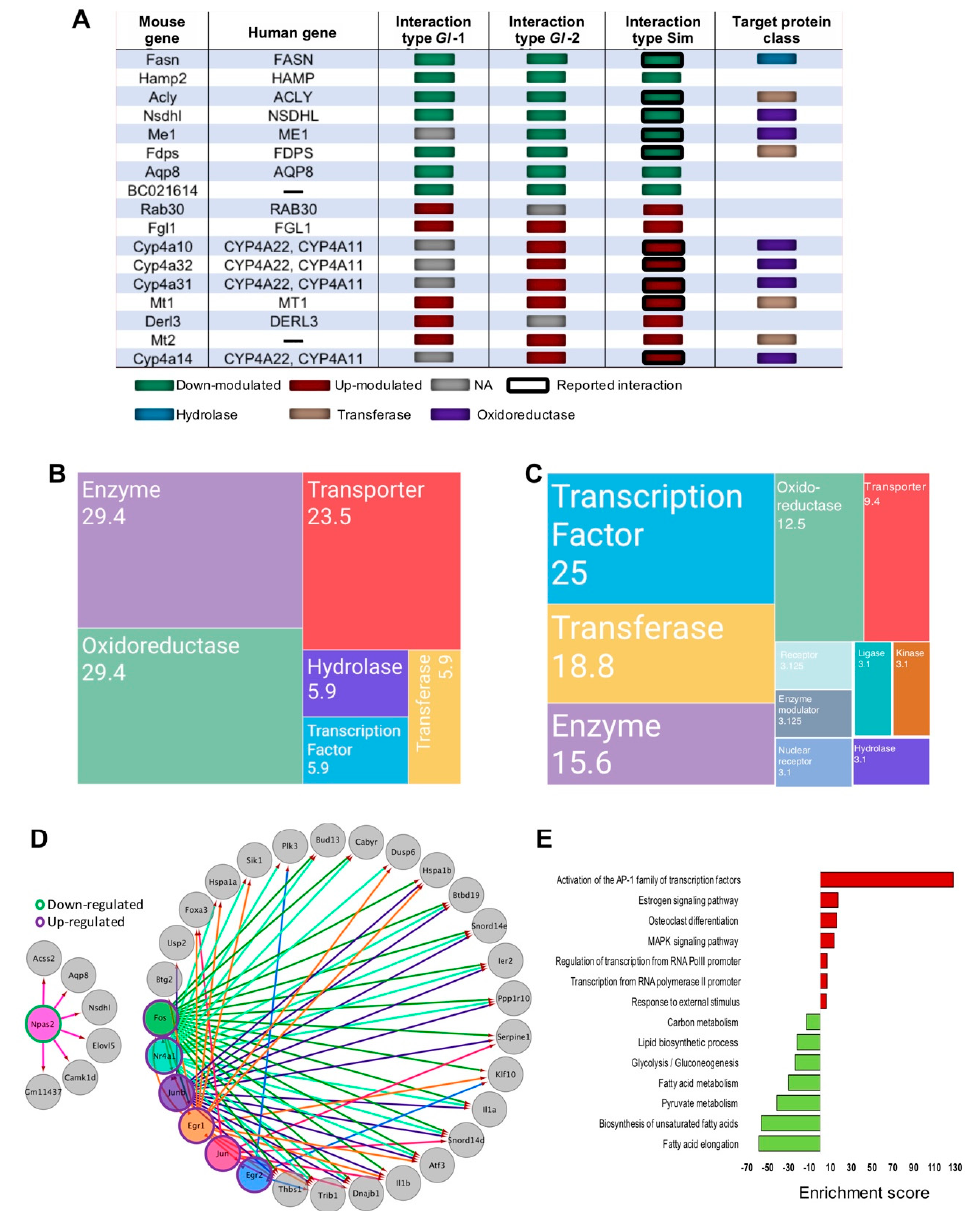
Figure 4. Genes associated to druggable metabolism, which are modulated by the intervention of Ganoderma lucidum extracts ( Gl -1, Gl -2) or simvastatin (Sim), under a high-cholesterol diet (HCD) given to C57BL/6 mice, as well as the transcription factor (TF) networks established. ( A ) Druggable genes targeted by simvastatin as annotated by the DGIdb database, showing their type of interaction and target protein classes in comparison with those from Gl extracts. Green or magenta shaded boxes represent expression status in mice hepatic tissue or druggable genes. Mosaic plot showing the frequency of target classes modulated by Gl -1 ( B ) or Gl -2 ( C ) extract consumption. Each rectangle represents a category annotated by the Drug Repurposing Hub (www.broadinstitute.org/drug-repurposing-hub) and the DGIdb databases, while numbers within rectangles indicate percentage of druggable Gl modulated genes in each category. ( D ) Regulatory network of transcription factors and target genes. Shaded circles represent TFs, while gray circles indicate target genes. Outer green or magenta circles indicate the expression status of TFs. The regulatory network shows direct interactions between altered TFs and altered gene targets showing a significant positive correlation in their expression values. ( E ) Over-representation pathway analysis of annotated and correlated TF target genes. Bars show the fold-enrichment of the significantly enriched ( p < 0.05) pathways. NA = Not